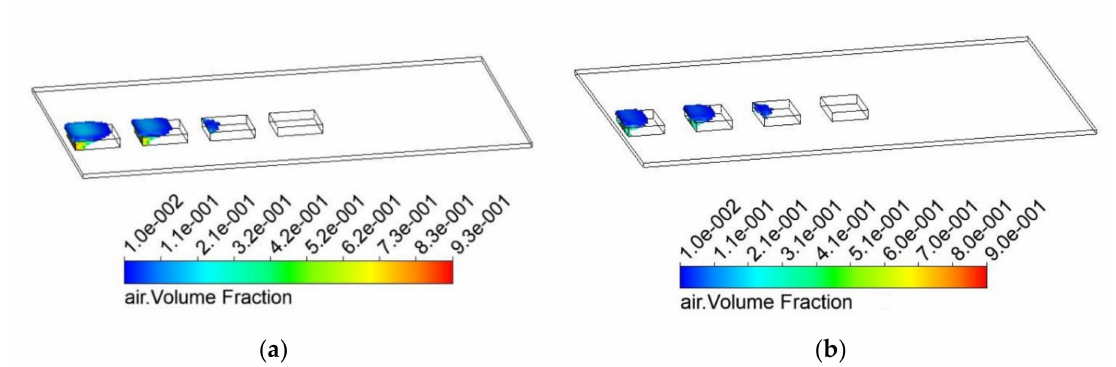
Figure 30. The air volume fraction is generated by a partial texturing configuration using Set A cavitation coe ffi cients and a saturation pressure of − 0.7 bar. Gap 5 µ m, sliding velocity 10 m / s. Highlighted only the volumes of the mesh where the volume fraction of air is greater than 1%. ( a ) Dimples side 50 µ m. ( b ) Dimples side 40 µ m. The textured portion remains